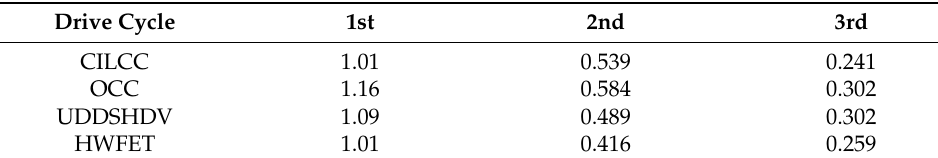
Table 10. The 3-speed optimal gear ratio under the drive cycle.